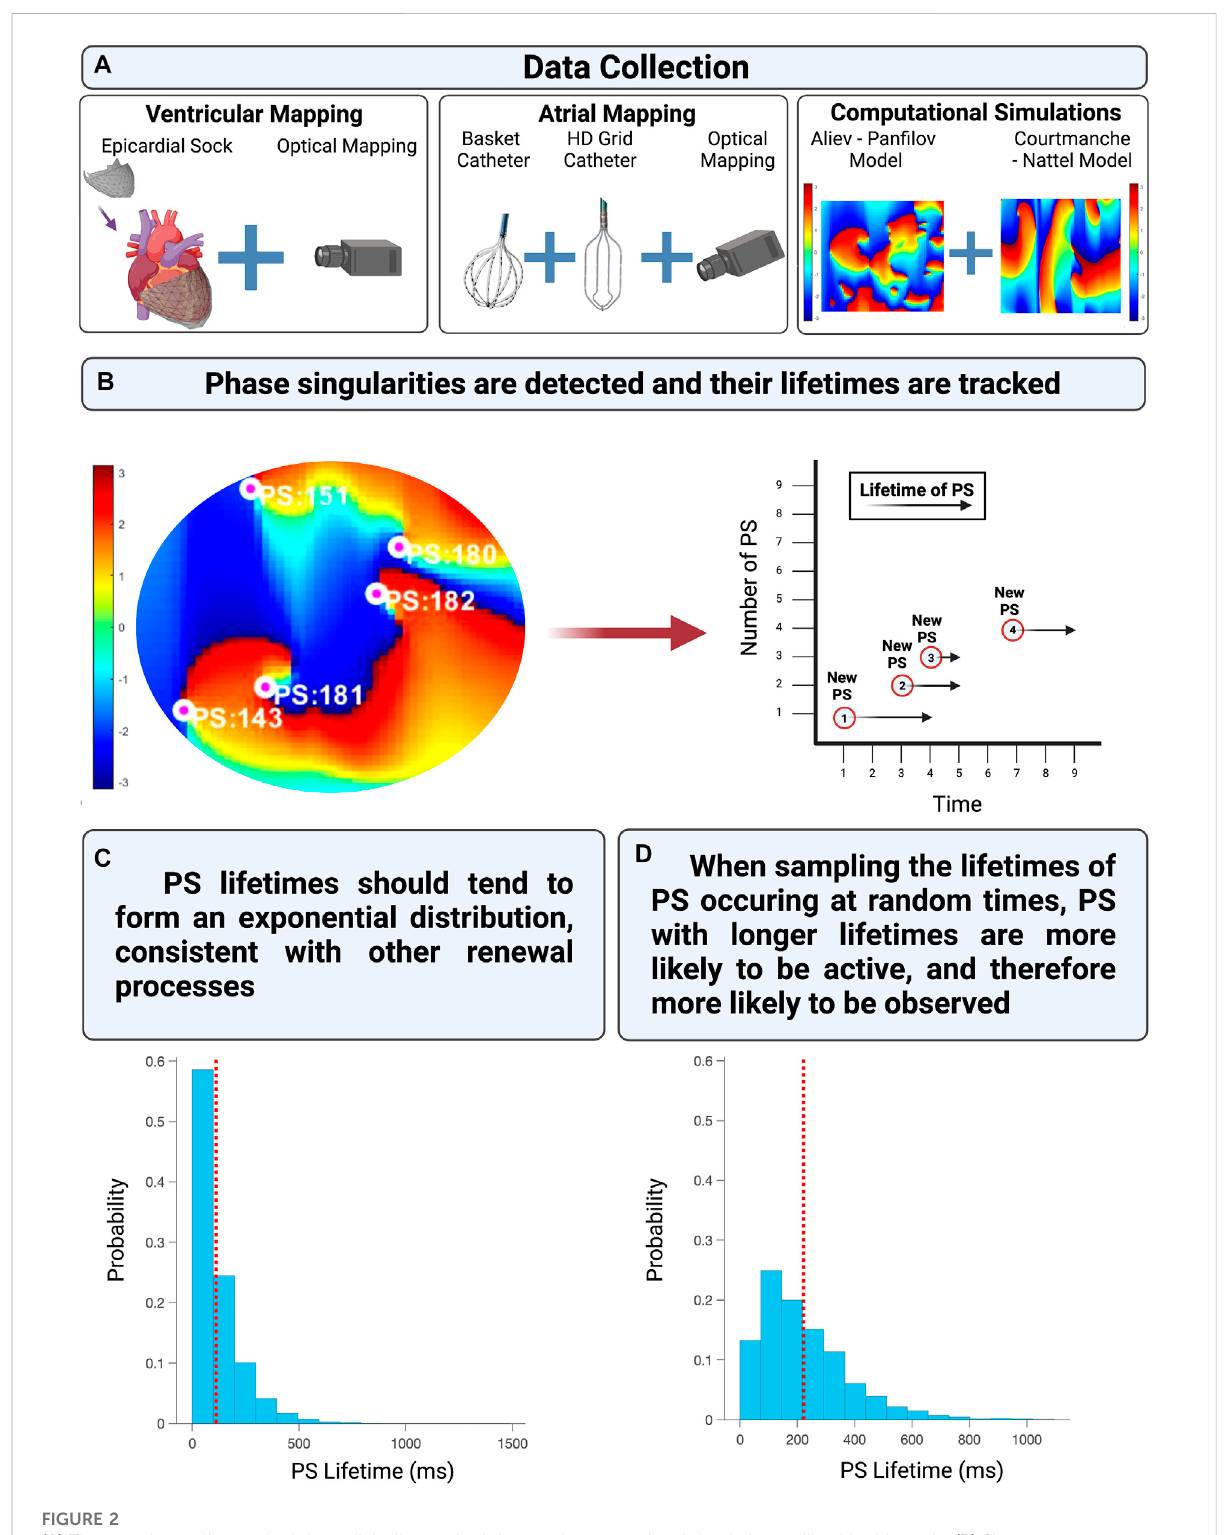
FIGURE 2 (A) The experimentally acquired data, clinically acquired data, and computational simulations utilized in this study. (B) Shows presents an example of PS detected and tracked on a phase map. (C) Demonstrates the distribution of PS lifetimes when all PS are properly sampled from an epoch of fi brillation. (D) Demonstrates the distribution of PS lifetimes when only PS present at a randomly chosen timepoint (such as the commencement of a recording) are